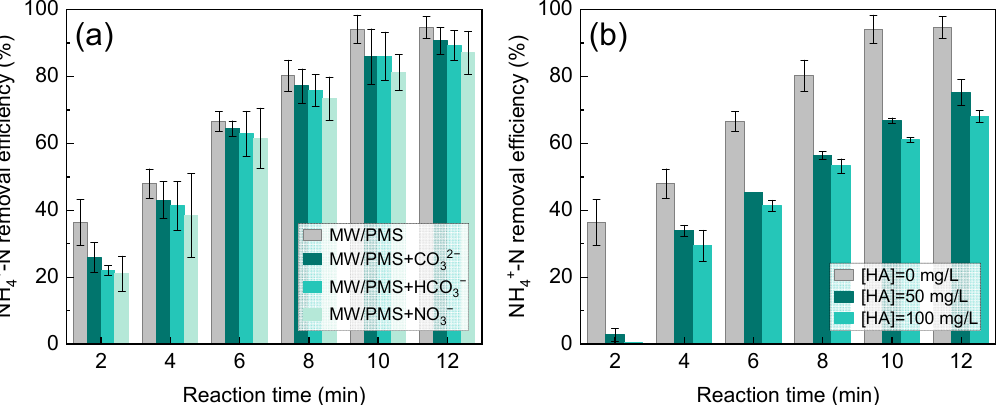
Figure 5. Effects of inorganic anions ( a ) and humus ( b ) on ammonia nitrogen removal in the MW/PMS system under a high-Cl − background. Reaction conditions: MW power = 160 W, [PMS] 0 = 10 mM, [Cl − ] 0 = 17.00 mM, [NH 4+ -N] 0 = 60 mg/L, [inorganic anion] = 100 mg/L, [HA] = 50, 100